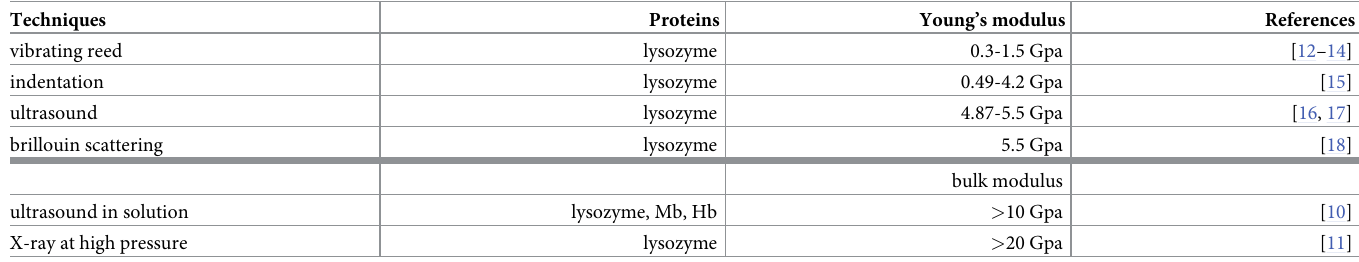
Table 1. A summary of studies on the elasticity of proteins using protein crystals (top half), or compressibility measurements (bottom half).